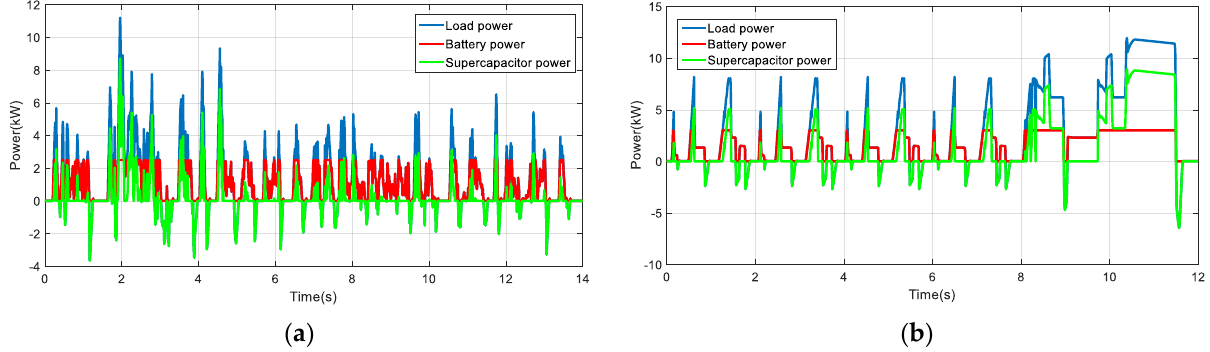
Figure 10. The load power and its split results: ( a ) Urban Dynameter Driving Schedule (UDDS) cycle; ( b ) New European Driving Cycle (NEDC) cycle.